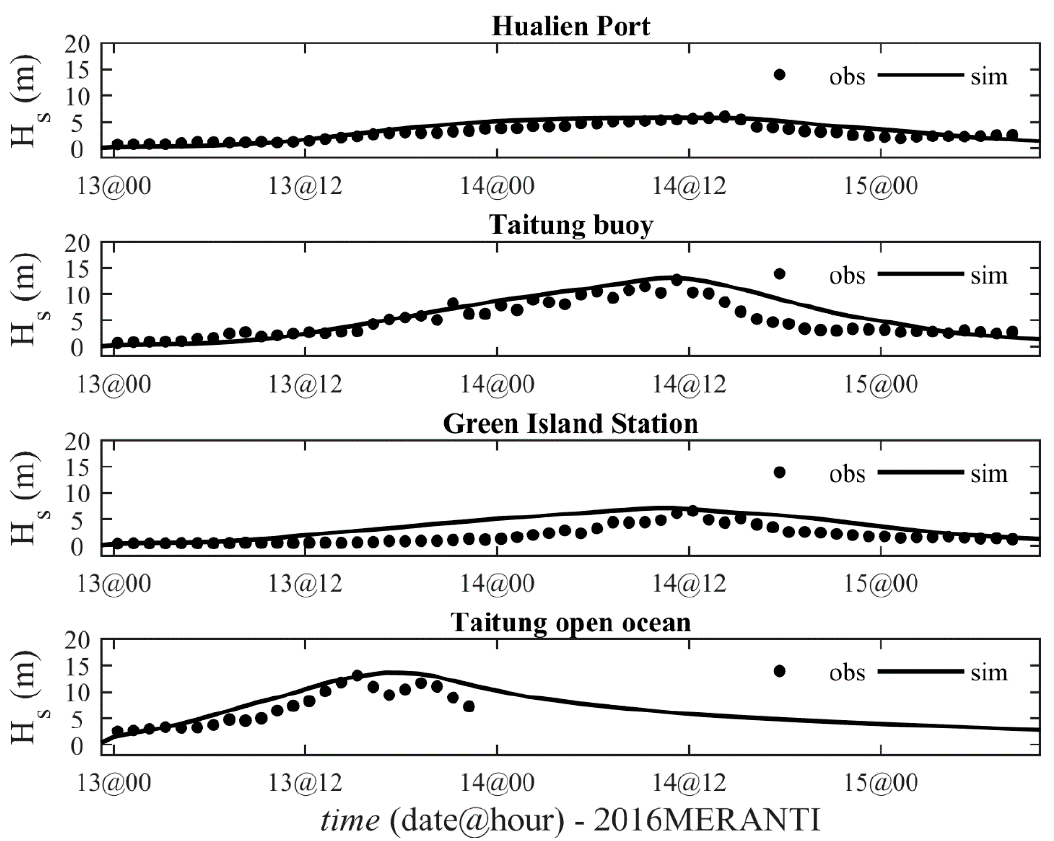
Figure 6. Comparisons of storm surges between model hindcasts and observations (Typhoon Meranti September 2017). Refer to Figure 5 for observation site locations.